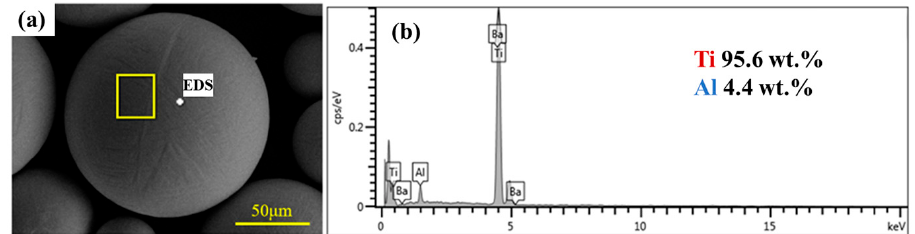
Figure 1. Raw material characterization of Ti powder. ( a ) Morphological characterization by SEM. ( b ) Element content characterization by EDS.